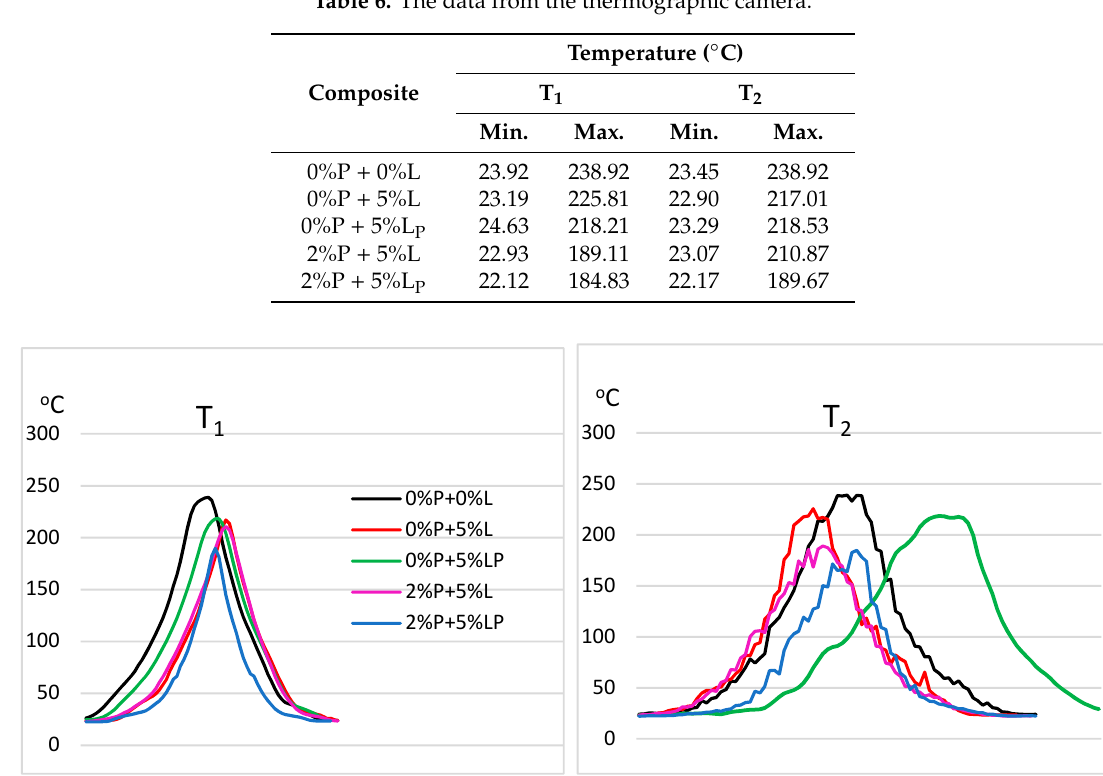
Figure 11. Flame temperature curves for the distribution of measuring points along the horizontal (1) and vertical (2) curves (T 1 and T 2 ) from the thermographic camera.